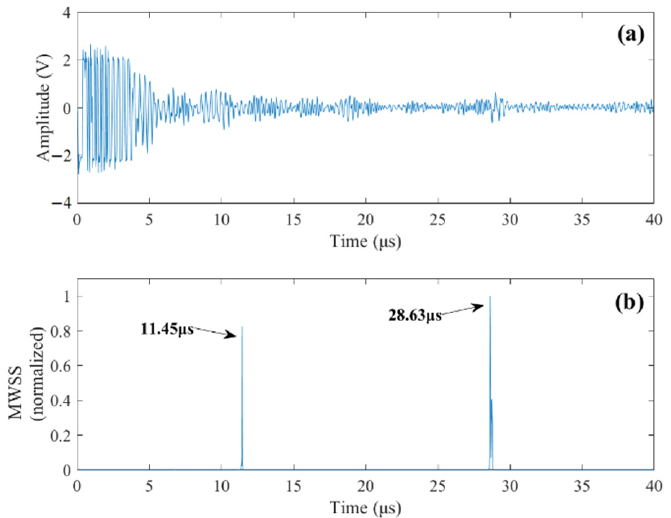
Figure 8. ( a ) A-scan signal of the upper flaw. ( b ) MWSS values revealing the time delays of the upper flaw echo and bottom reflection. Table 2. Detection results of the proposed method for case 1.